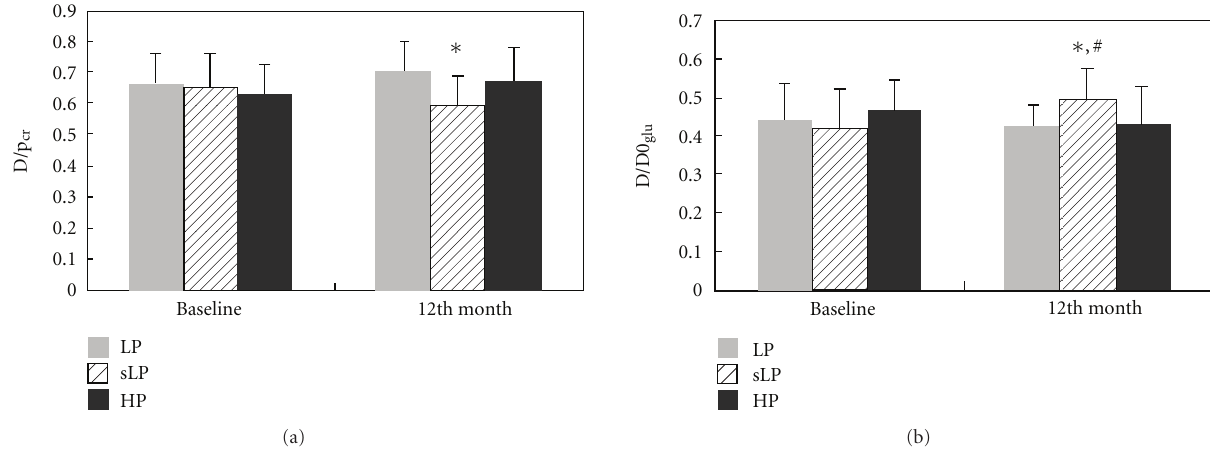
Figure 1: Peritoneal equilibration test (PET) results in the 53 PD patients, grouped according to the diet that they are randomized to during 12 month followup. (a) shows D/P cr (dialysate-to-plasma concentration ratio for creatinine at 4 hours). (b) shows D/D0 glu (dialysate glucose at 4 hours to baseline dialysate glucose concentration ratio). ∗ P < 0 . 05, compared with the other two groups. # P < 0 . 05, compared with